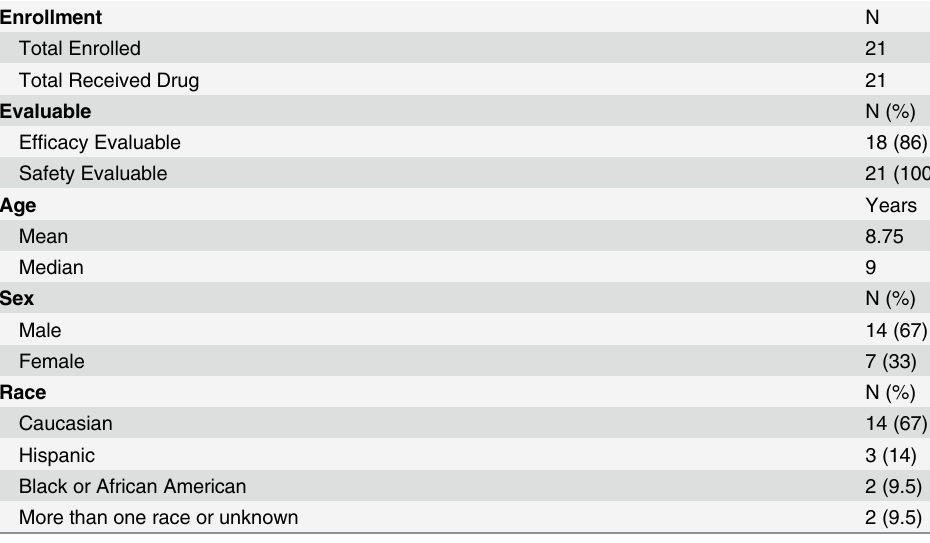
Table 1. Characteristics of patients enrolled in NMTRC